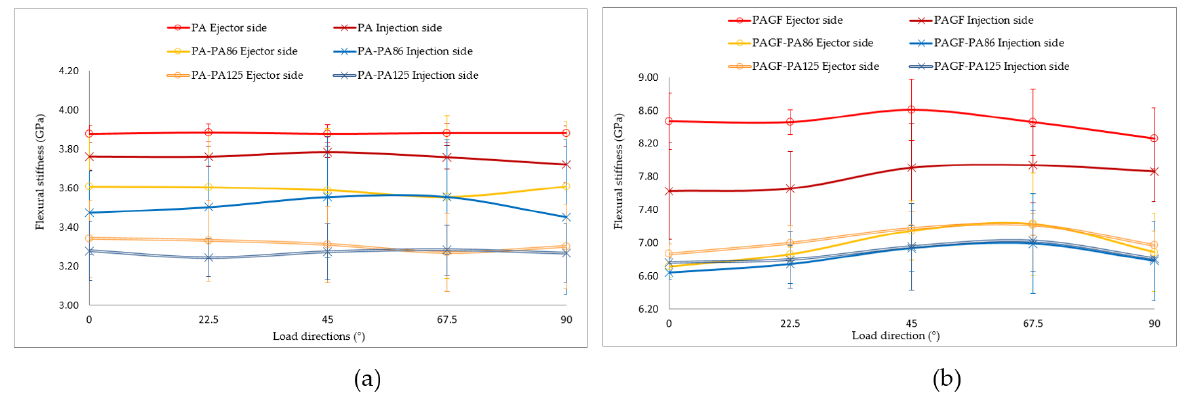
Figure 16. Comparison of flexural test results according to the impact side on the sample between composites and matrix material without reinforcement. ( a ) PA matrix. ( b ) PAGF matrix.